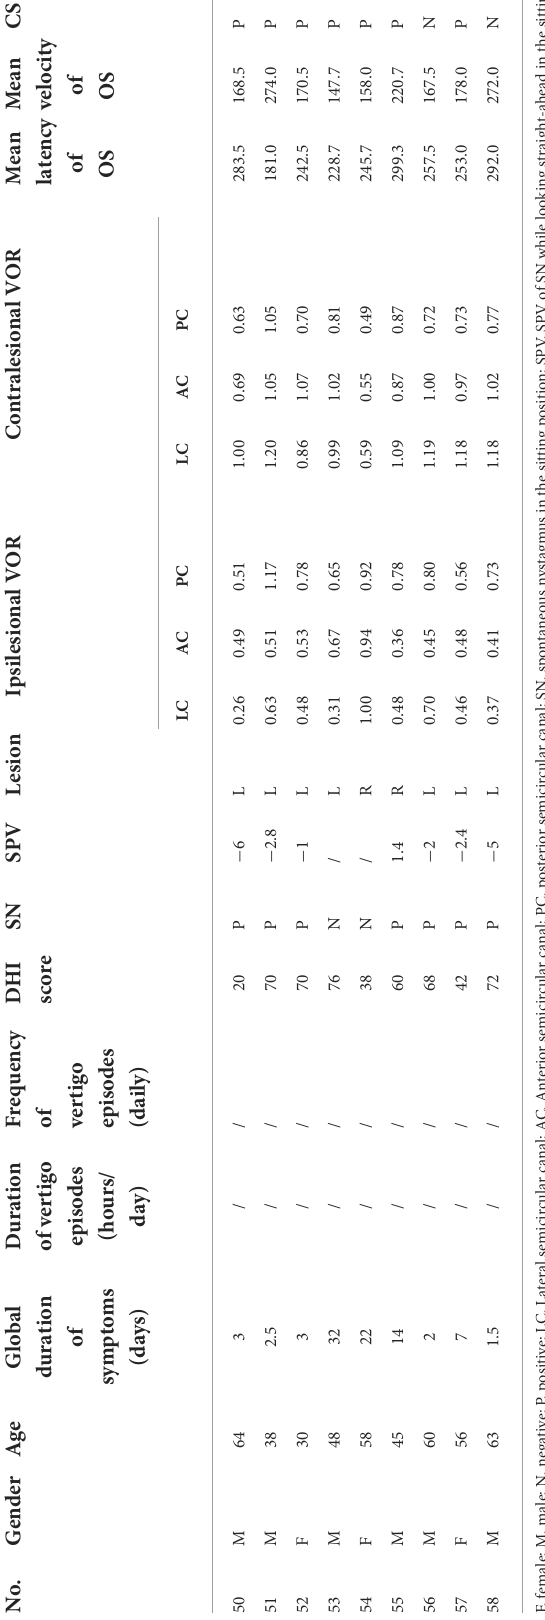
TABLE 2 Clinical characteristics of all patients with vestibular